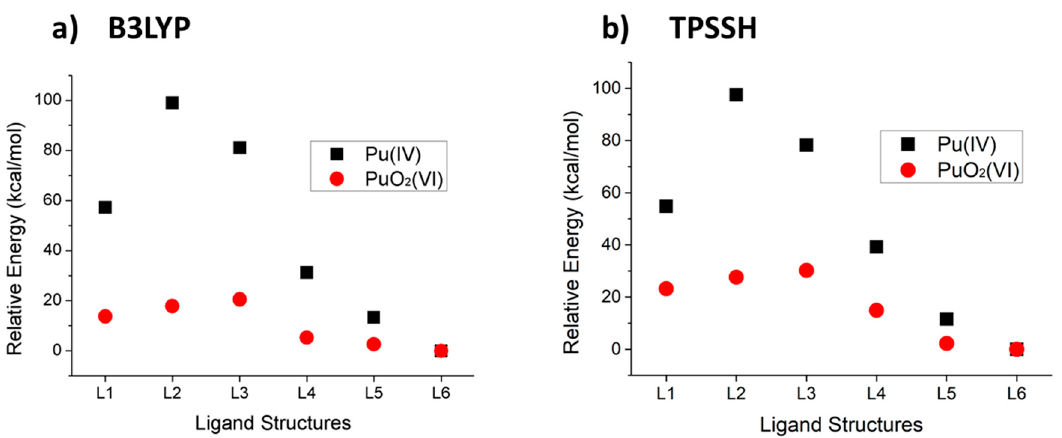
Figure 3. Relative energy of each structure compared with the most stable complex (Pu–L6) using different functionals: ( a ) B3LYP, ( b ) TPSSH.